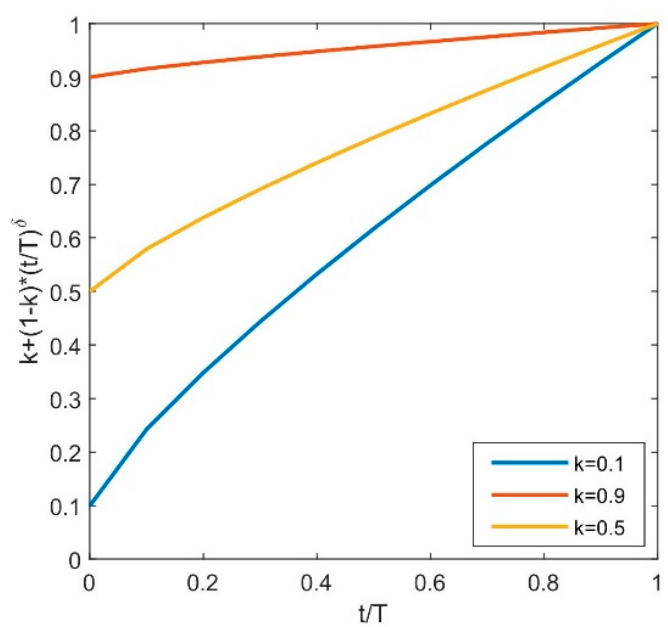
Figure 3. The influence of concession factor k on k + ( 1 − k ) ∗ ( t / T ) δ . By setting k = 0.4, we respectively examined the changes of k + ( 1 − k ) ∗ ( t / T ) δ under T = 3, T = 5 and T = 7.